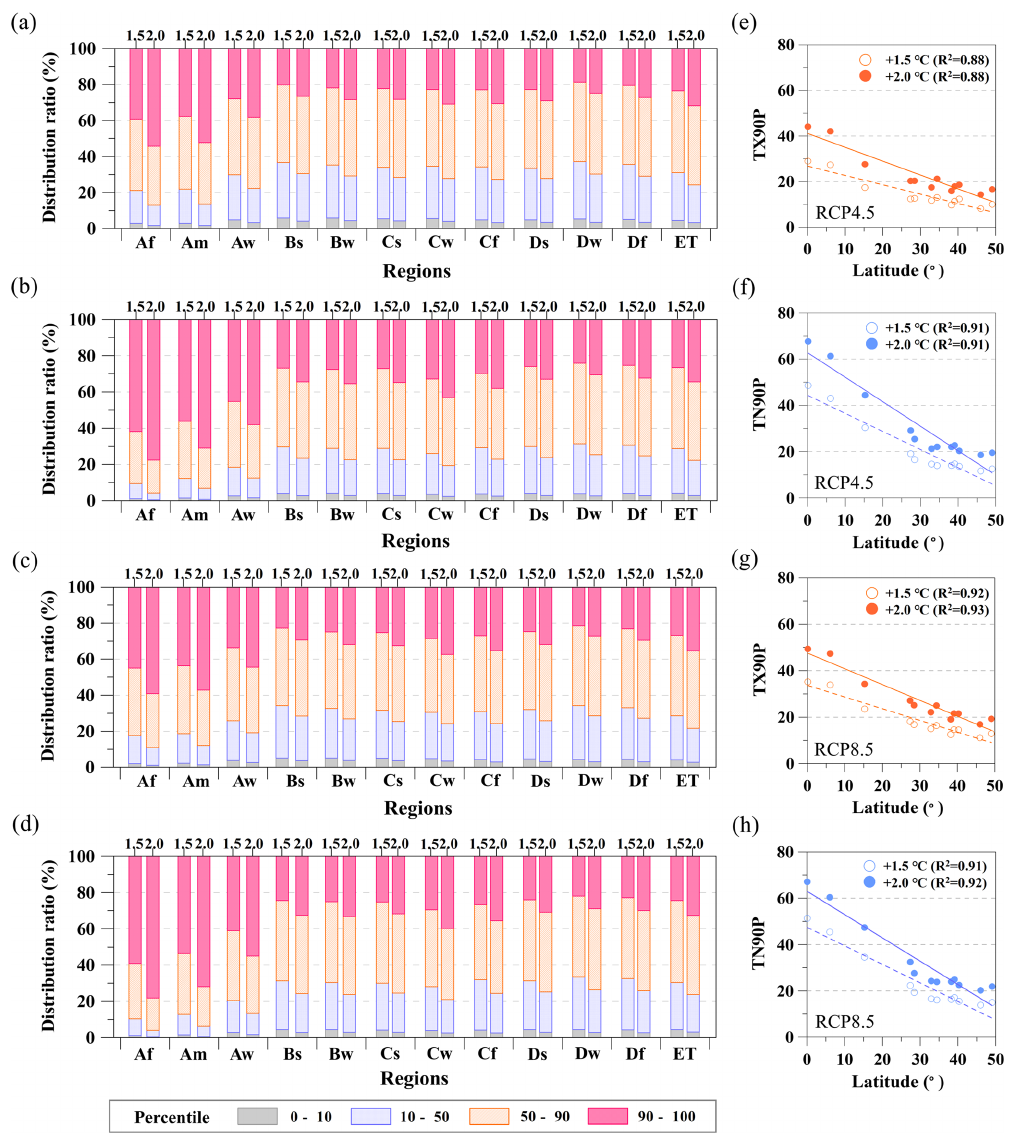
Figure 6. Relative changes in the (a, c) maximum temperature (TX) and (b, d) minimum temperature (TN) according to four percentile ranges under 1.5 and 2.0 ◦ C of global warming compared with the reference period (REF). (e, g) The relationship between the average latitude of each climate zone and the relative change in the 90th percentile of the maximum temperature (TX90P) under global warming. (f, h) The relationship between the average latitude of each climate zone and the relative change in the 90th percentile of the minimum temperature (TN90P) under global warming. Each circle in (e–h) denotes a representative value for an individual climate zone. The solid (dashed) line in (e–h) represents the regression relationship between two variables with the coefficient of determination ( R 2 ) under 1.5 ◦ C (2.0 ◦ C) of global